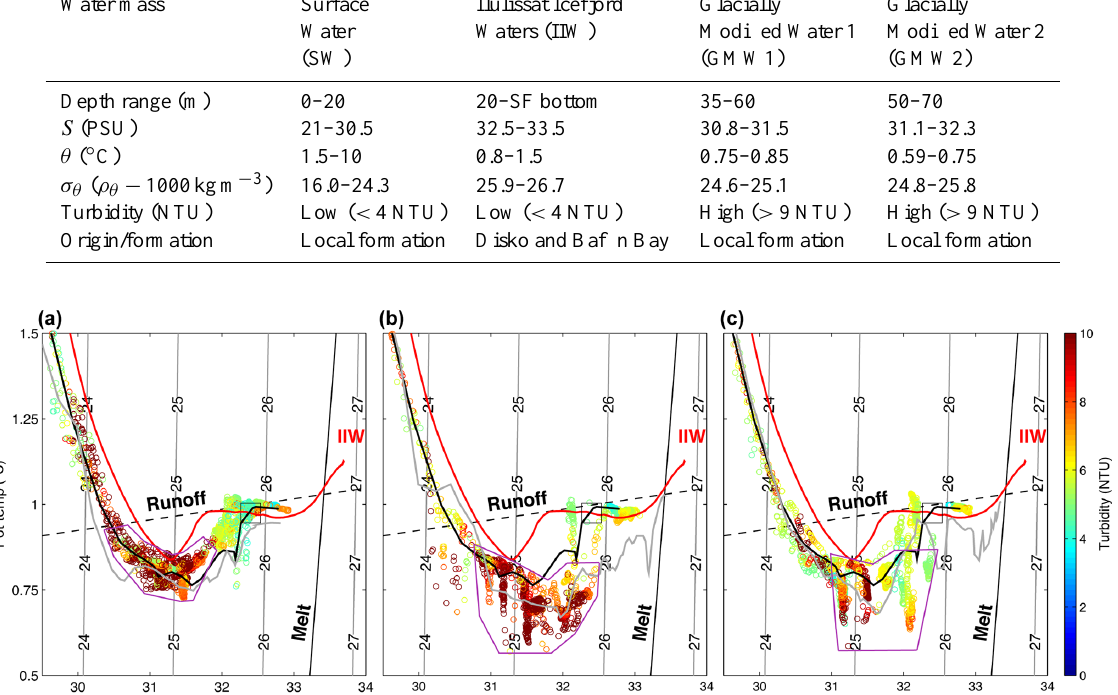
Figure 6. Turbidity of glacially modified waters. θ ( ◦ C) and S (PSU) profiles from the regions along R4 and R5 outlined in blue (GMW1 region) (a) , gold (GMW2 region) (b) , and white (the region between GMW1 and GMW2) (c) in Fig. 3, with turbidity plotted as the color of the point. CTD1 (a) , CTD2 (b) , and CTD3 (c) are plotted in grey. The GMW region in θ/S space is outlined in purple. The average of all R4 and R5 measurements and the ambient fjord waters are plotted in black and red, respectively. Black square along ambient fjord water profile shows θ/S properties at sill depth